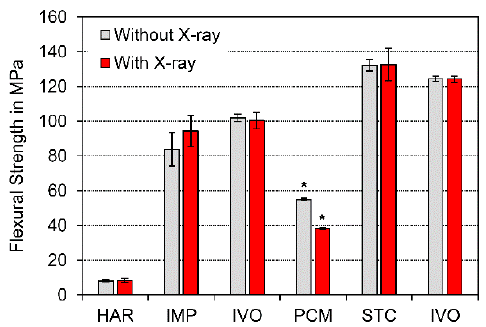
Figure 3. Flexural strength ( p < 0.05 → *).